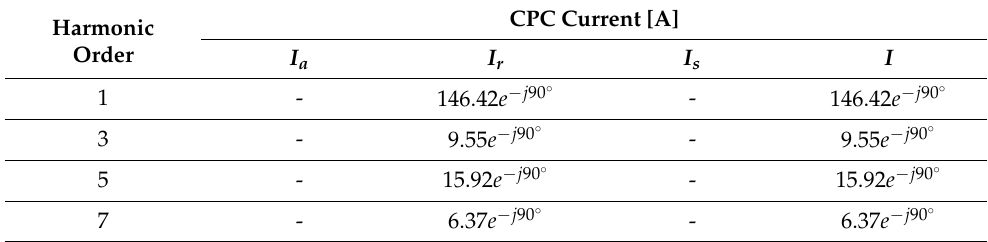
Table 11. List of complex values of currents in developed Budeanu’s theory. Harmonic Order